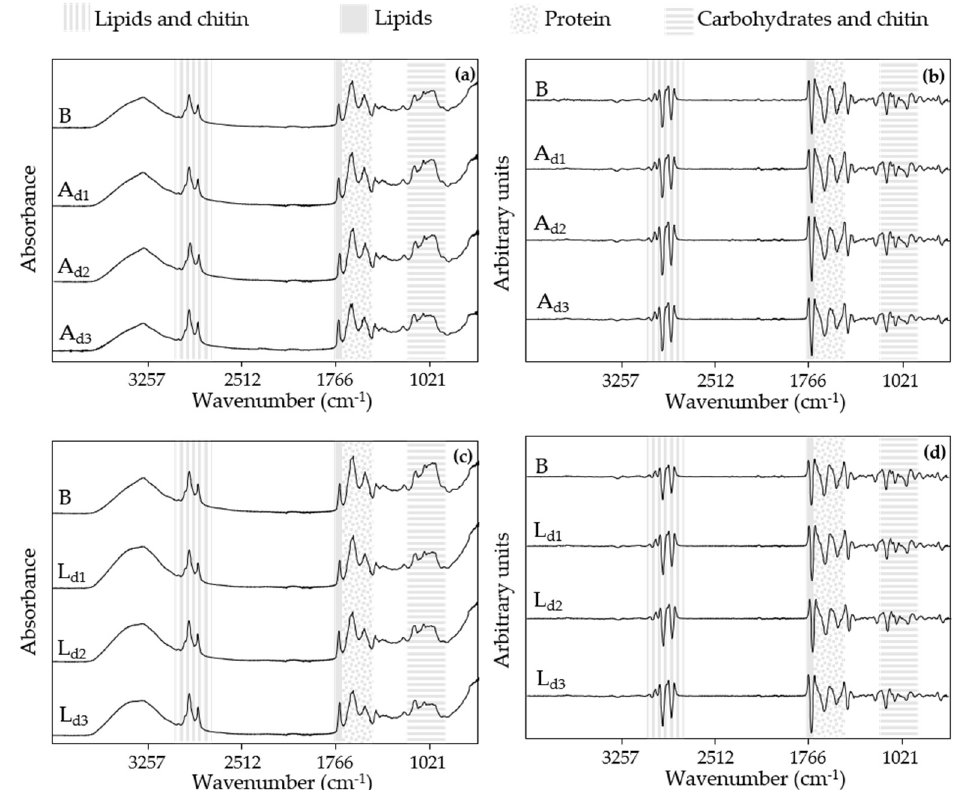
Figure 3. Raw MIR spectra (4000 to 800 cm − 1 ) from doughs with ( a ) different concentrations of A. diaperinus (A d1 , A d2 , and A d3 ) and ( b ) the transformed spectra (vector length normalized and second derivative, 13 points). Graphs ( c ) show the raw mid-infrared spectra of different concentrations of L. migratoria (L d1 , L d2 , and L d3 ) and ( d ) the transformed spectra. Abbreviations used: B, blank dough with 0% insect powder; A d1 , dough with 4.6% of A. diaperinus powder; A d2 , dough with 9.3% of A. diaperinus powder; A d3 , dough with 13.9% of A. diaperinus powder; L d1 , dough with 4.6% of L. migratoria powder; L d2 , dough with 9.3% of L. migratoria powder; L d3 , dough with 13.9% of L. migratoria